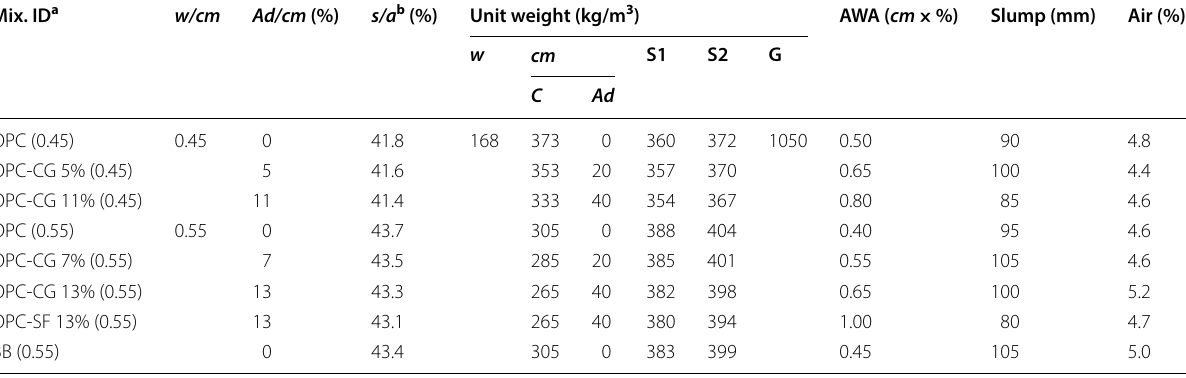
Table 3 Mixture proportions and fresh properties of